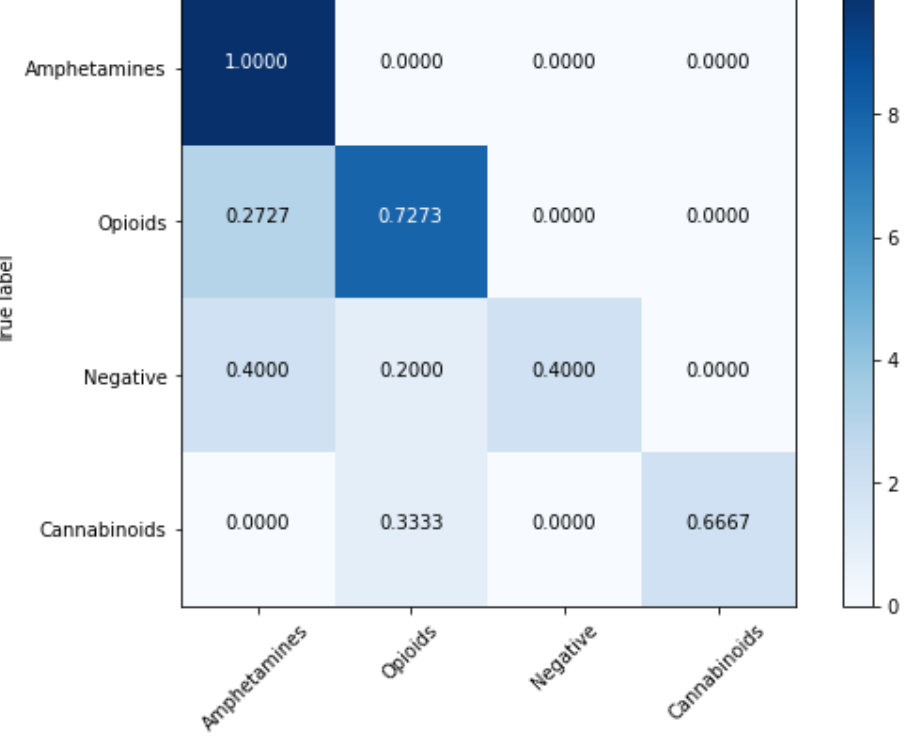
Figure 8. Confusion matrix for the Gradient Boosting model.